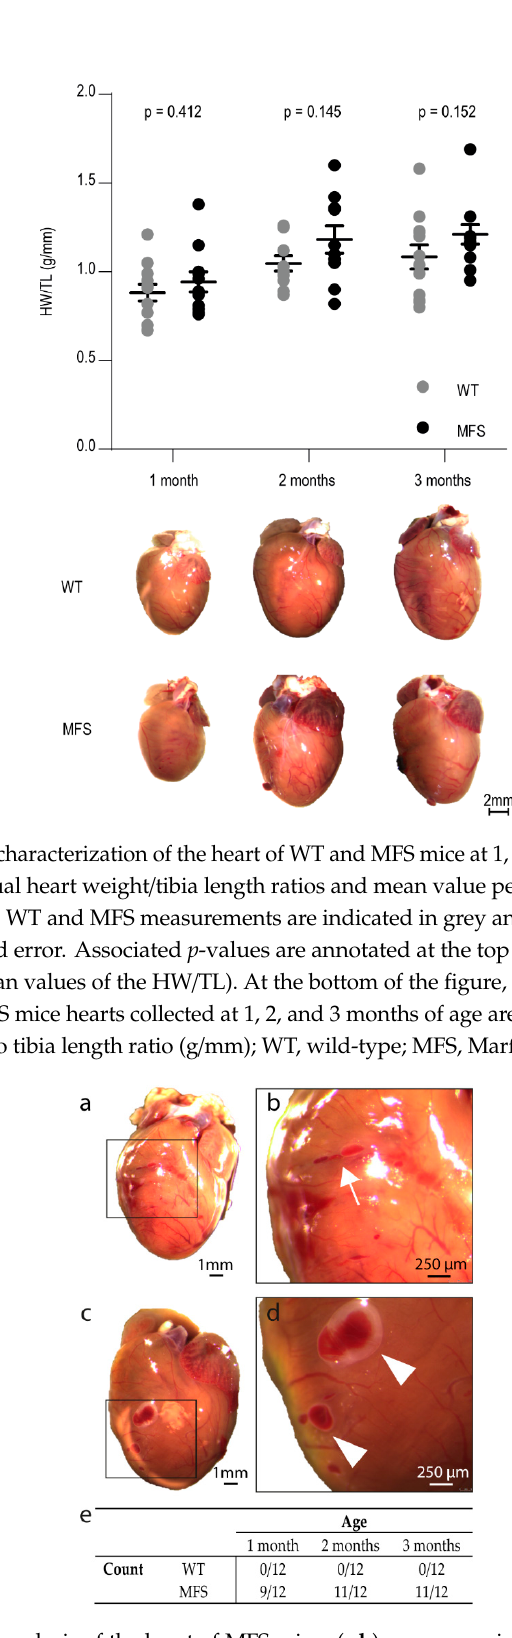
Figure 2. Macroscopic analysis of the heart of MFS mice. ( a , b ): macroscopic view of the heart of a MFS mouse presenting a tear at the level of the right ventricular wall. The tear is indicated with a white arrow in panel ( b ). ( c , d ): macroscopic view of the heart of a MFS mouse presenting vesicles at the level of the right ventricular wall. Vesicles are indicated with a white arrowhead in panel ( d ). ( e ): number of WT and MFS mice presenting cardiac lesions per age group. Scale bar of panels ( a , c ) = 1 mm, scale bar of panels ( b , d ) = 250 µm.